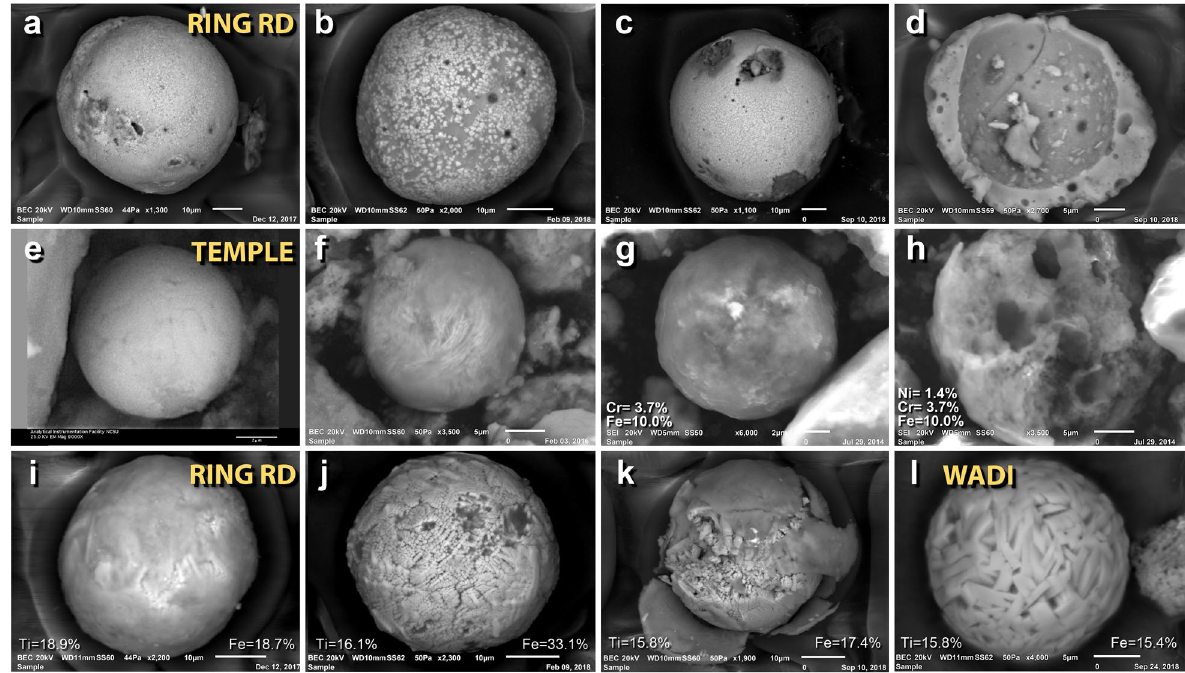
Figure 25. SEM images of mostly silica-rich spherules from TeH. ( a )–( d ) Representative spherules from the ring road on the lower tall. SEM images of iron-rich spherules. ( e )–( f ) Fe-rich spherules from the temple complex. ( g ) temple spherule containing ~ 3.7 wt.% Cr. ( h ) Broken, vesicular spherule from temple containing 1.4 wt.% Ni and 3.7 wt.% Cr. SEM images of titanium-rich spherules. Ti content of these ranges from 18.9